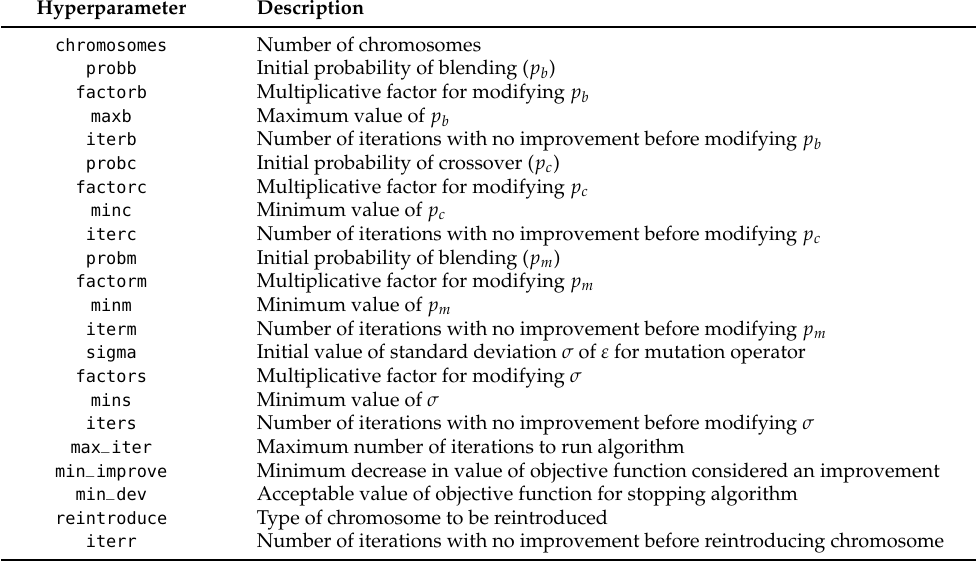
Table 1. Name and description of all hyperparameters used in the algorithm.